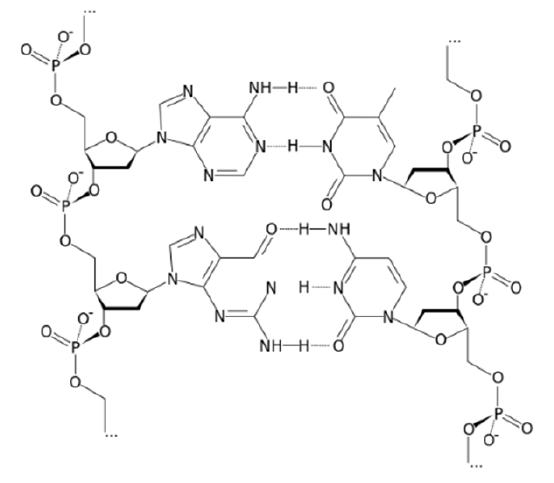
Figure 1. Structure of deoxyribonucleic acid (DNA).